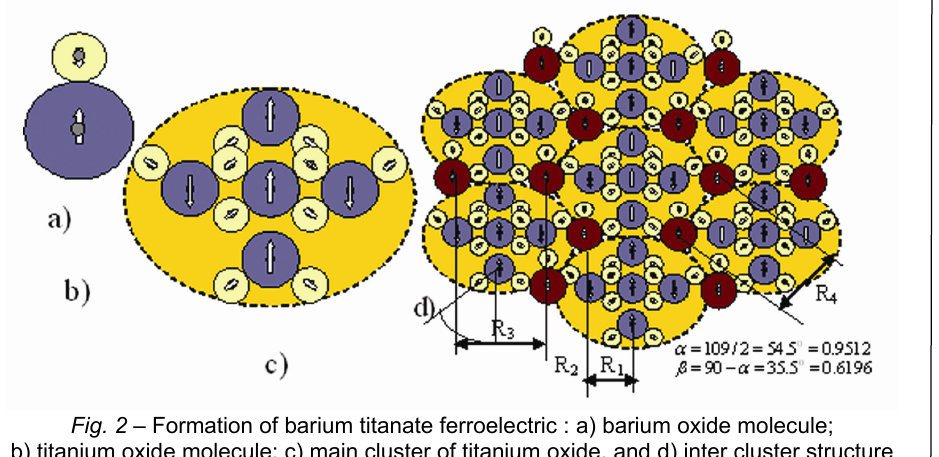
Fig. 2 – Formation of barium titanate ferroelectric : a) barium oxide molecule; b) titanium oxide molecule; c) main cluster of titanium oxide, and d) inter cluster structure of titanium oxide reinforced by barium oxide